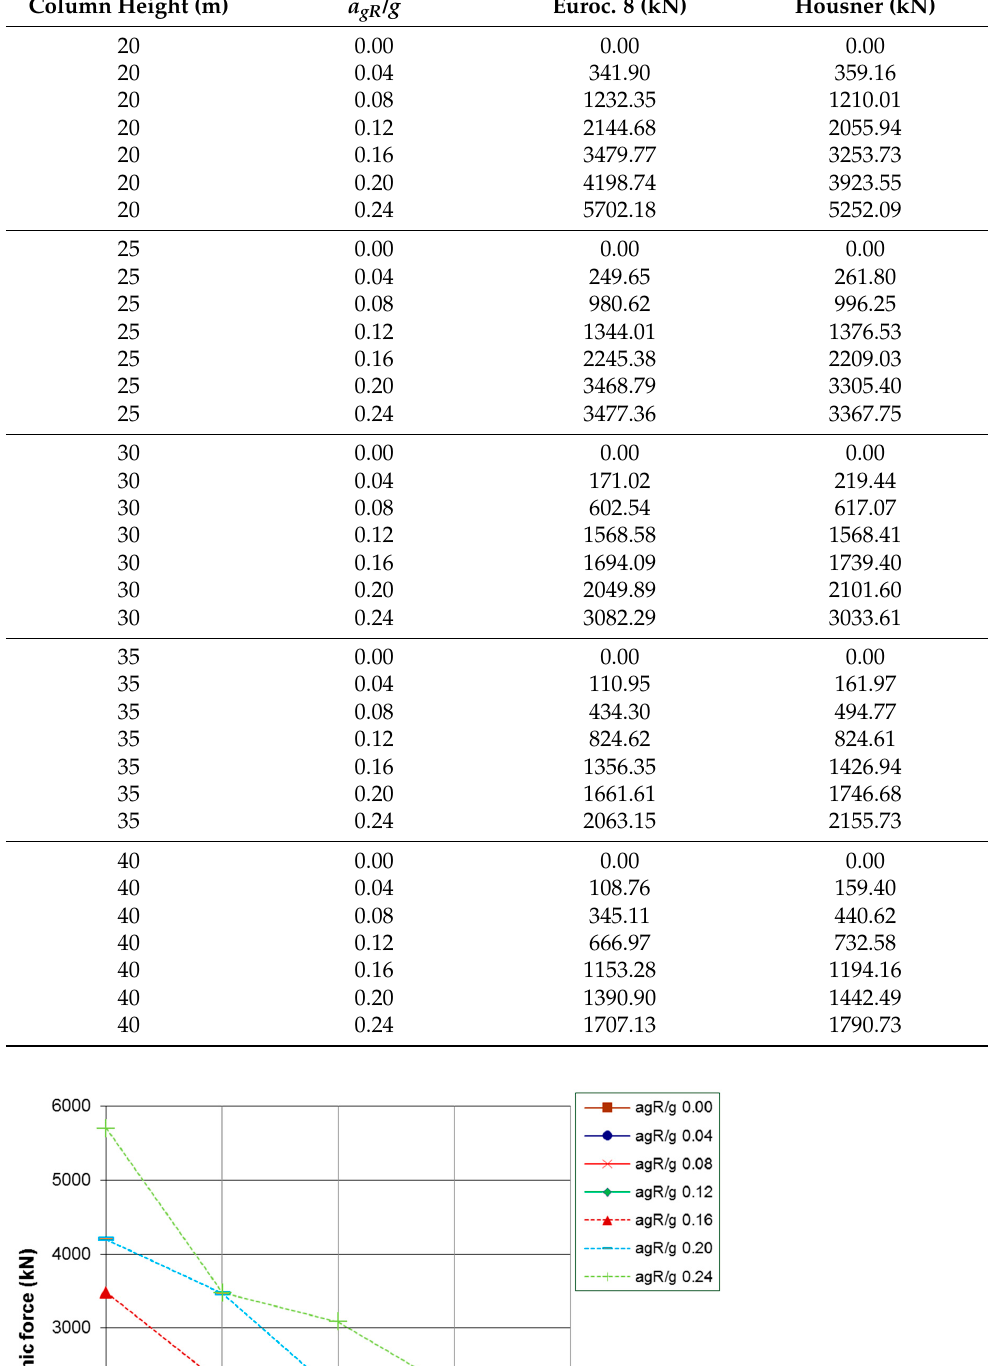
Table 5. Horizontal seismic forces (kN).